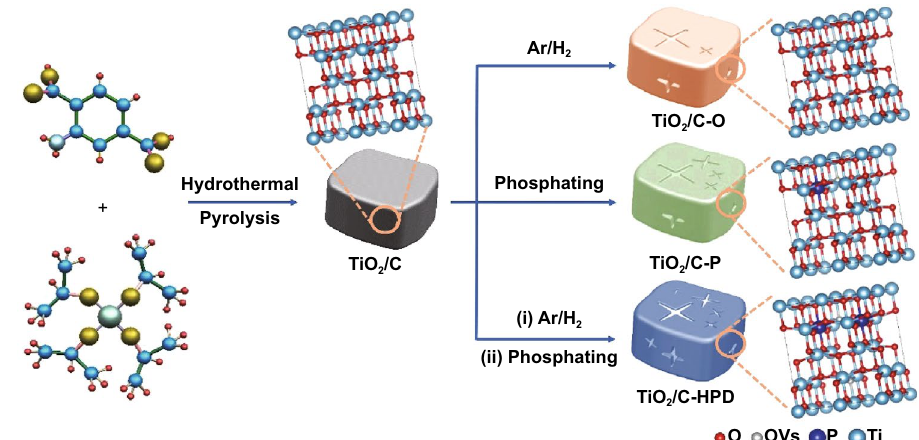
Fig. 1 Schematic illustration for the synthesis of the TiO 2 /C, TiO 2 /C-O, TiO 2 /C-P, TiO 2